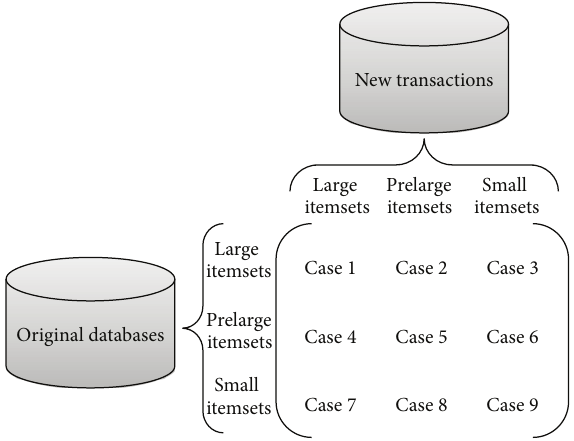
Figure 1: Nine cases when new transactions are inserted into existing